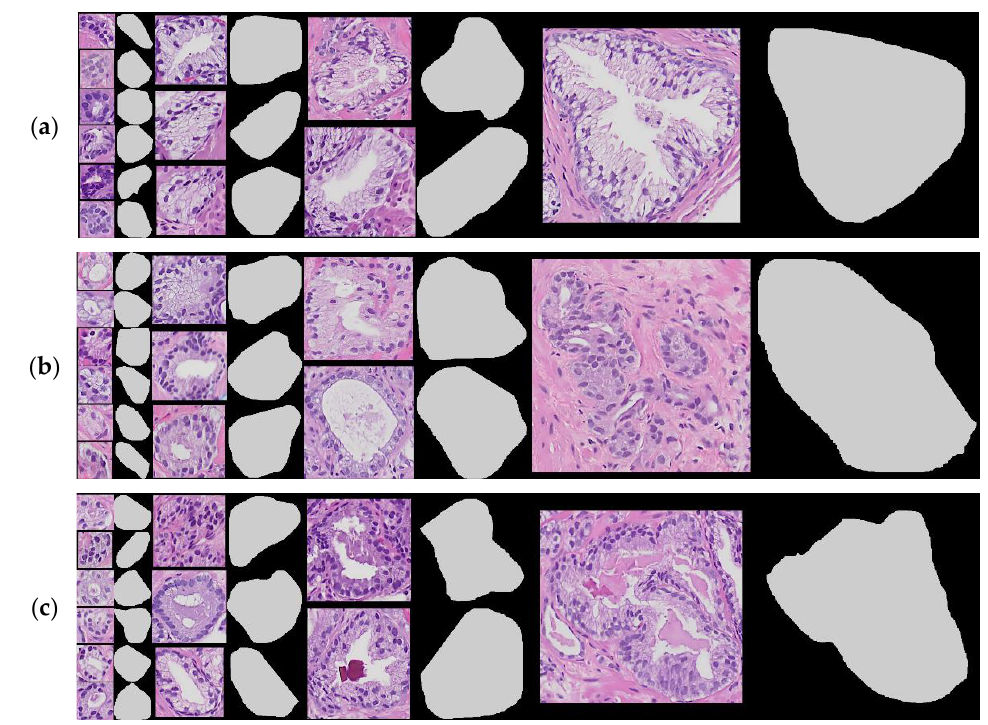
Figure 2. Sample selection of UM/MCC gland-level patches using the tight bounding-box technique paired with corresponding mask layer (on the right): ( a ) samples of benign, ( b ) samples of GS3, and ( c ) samples of GS4.